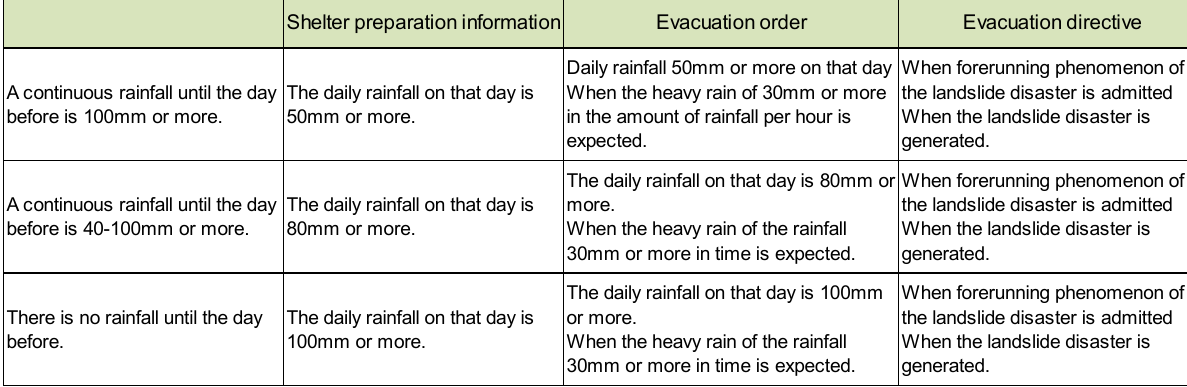
Table 4. Precaution shelter standard of sediment disaster Shelter preparation information Evacuation order Evacuation directive